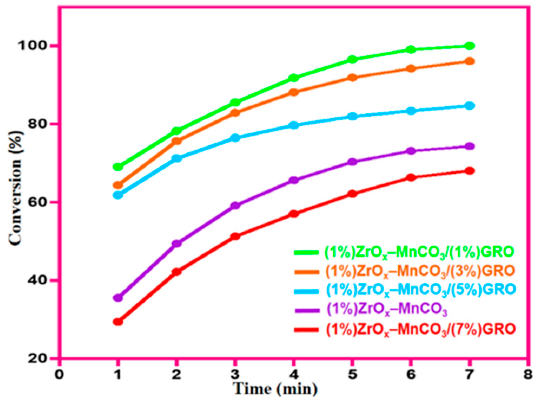
Figure 7. Graphical illustration of BzOH oxidation catalyzed by various catalysts with different percentages of GRO.